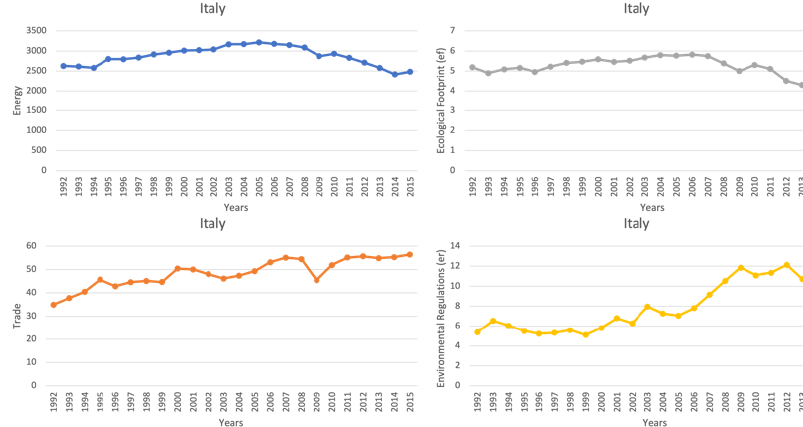
Figure 2. Data visualization for Italy.